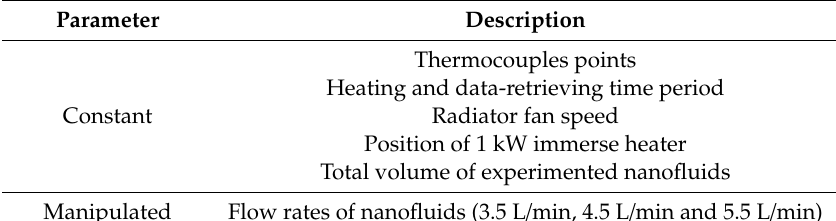
Table 1. Parameters and description of the variables of the